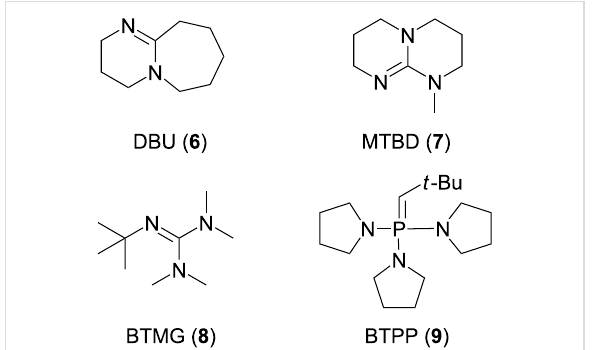
Figure 2: Chemical structure bases.